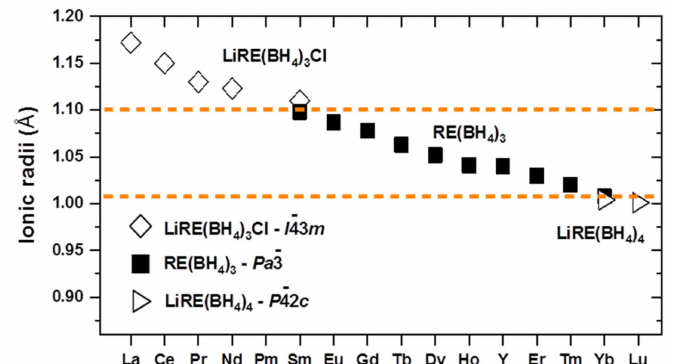
Figure 1. Overview of borohydride phases obtained by mechanochemical reactions of RECl3 and LiBH4. The ionic radius of RE 3 + cations in the solid-state are displayed in octahedral environment [388]. Reproduced with permission from Wegner, W.; Jaron, T.; Grochala, W. Polymorphism and hydrogen discharge from holmium borohydride, Ho(BH 4 ) 3 , and KHo(BH 4 ) 4 . International Journal of Hydrogen Energy, 2014, 39 , pp. 20024–20030, Copyright (2014), with permission from Elsevier.